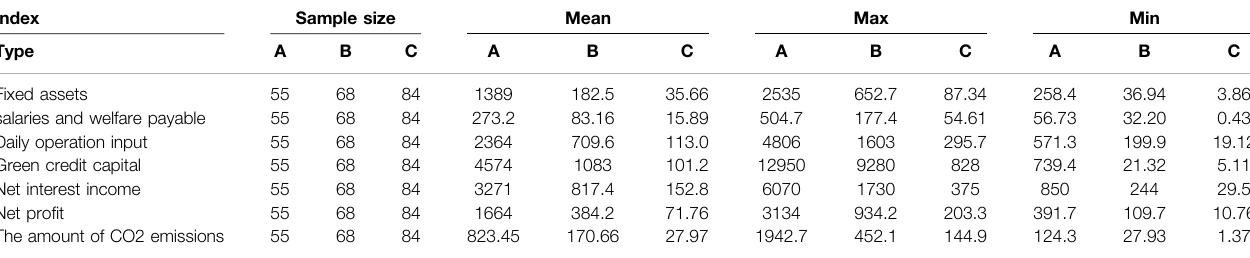
TABLE 4 | Descriptive Statistics of input-output Indicators from 2009 to 2019.